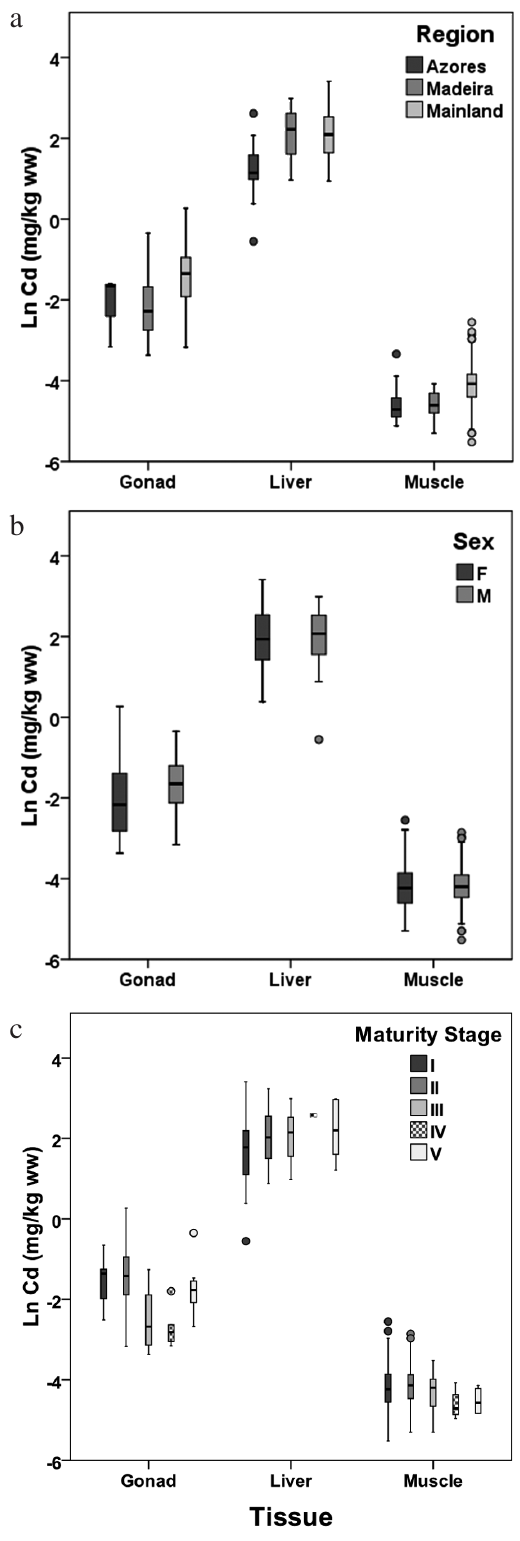
Fig . 2. – box plots of total mercury concentrations by (a) region, (b) sex, and (c) maturity stage. each box plot presents the median, the 1 st and 3 rd quartiles, the maximum and the minimum. the circles correspond to the outliers and the asterisks are the extreme outliers.